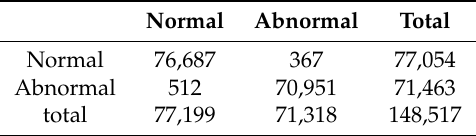
Table 5. The confusion matrix of two state evaluation in NSL-KDD.